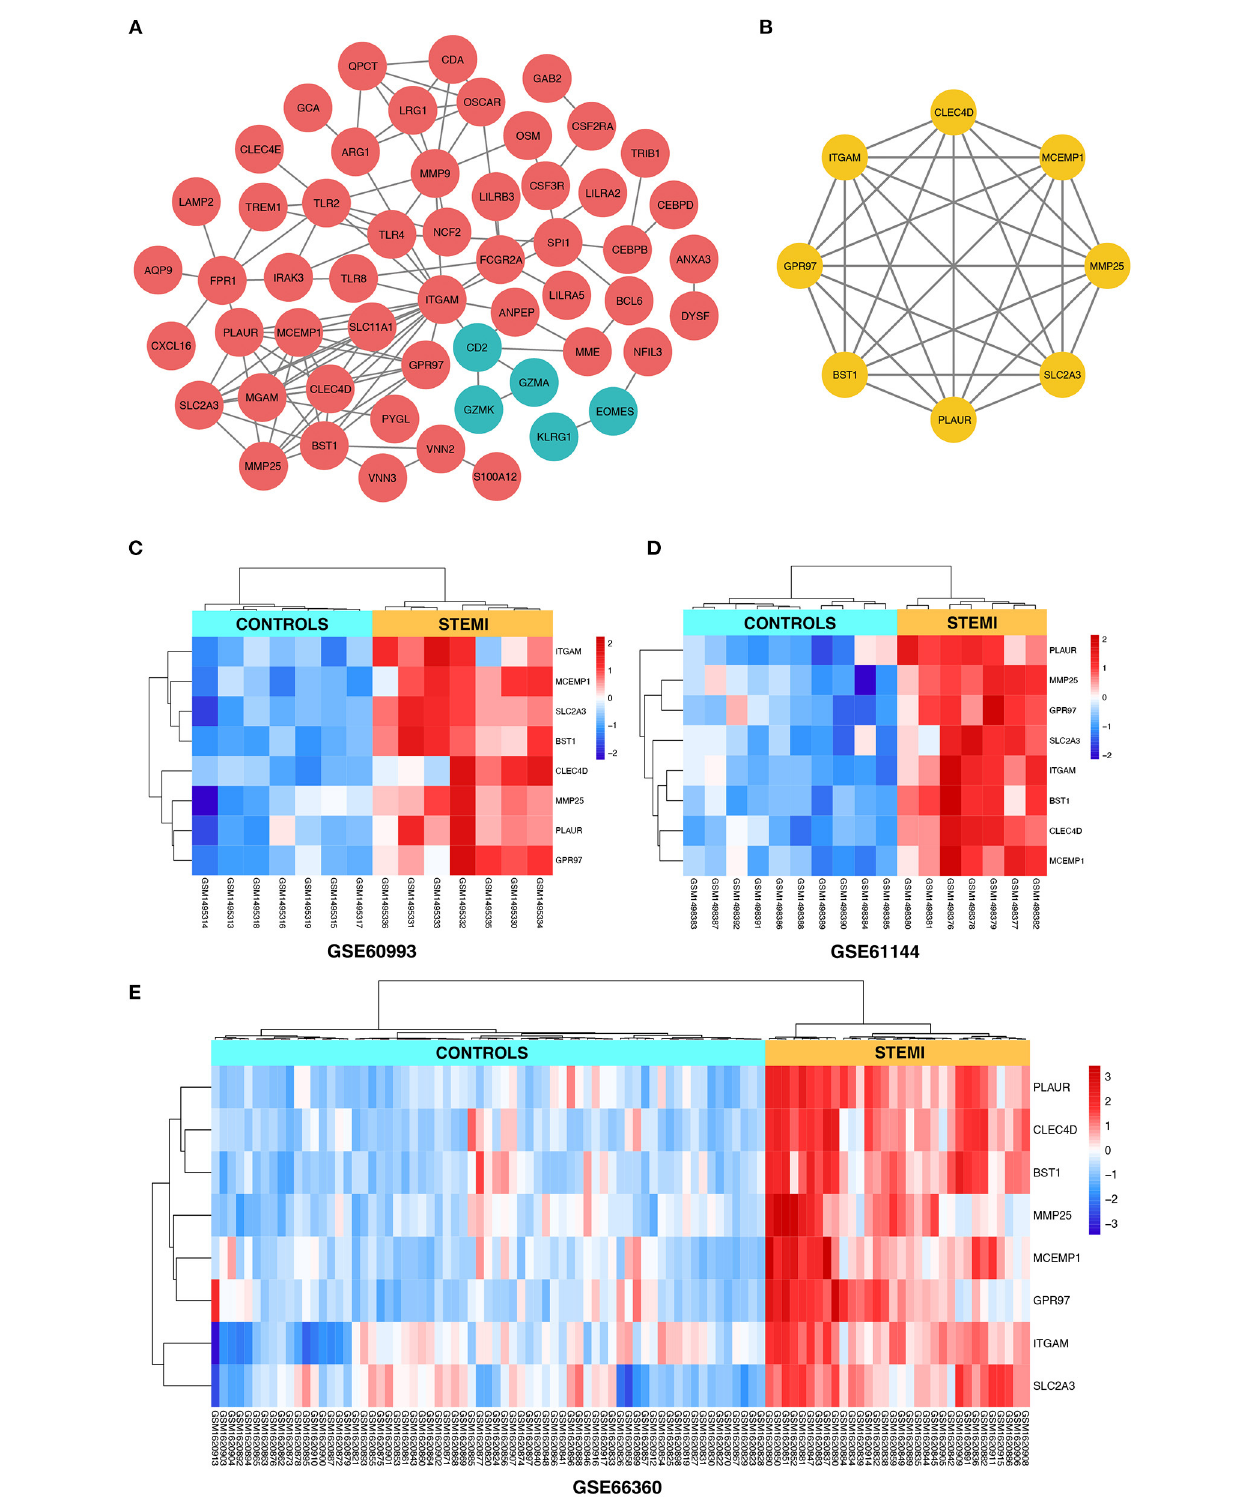
FIGURE 4 | (A) The construction of the PPI network based on the DEGs. The red ellipse represents upregulated DEGs, the green ellipse represents downregulated DEGs. (B) The hub gene cluster with the highest scores in the PPI network is displayed by the yellow ellipse. (C–E) The heatmaps with clustering analysis showed the normalized expression values of hub genes in GSE60993, GSE61144, and GSE66360 datasets, respectively.